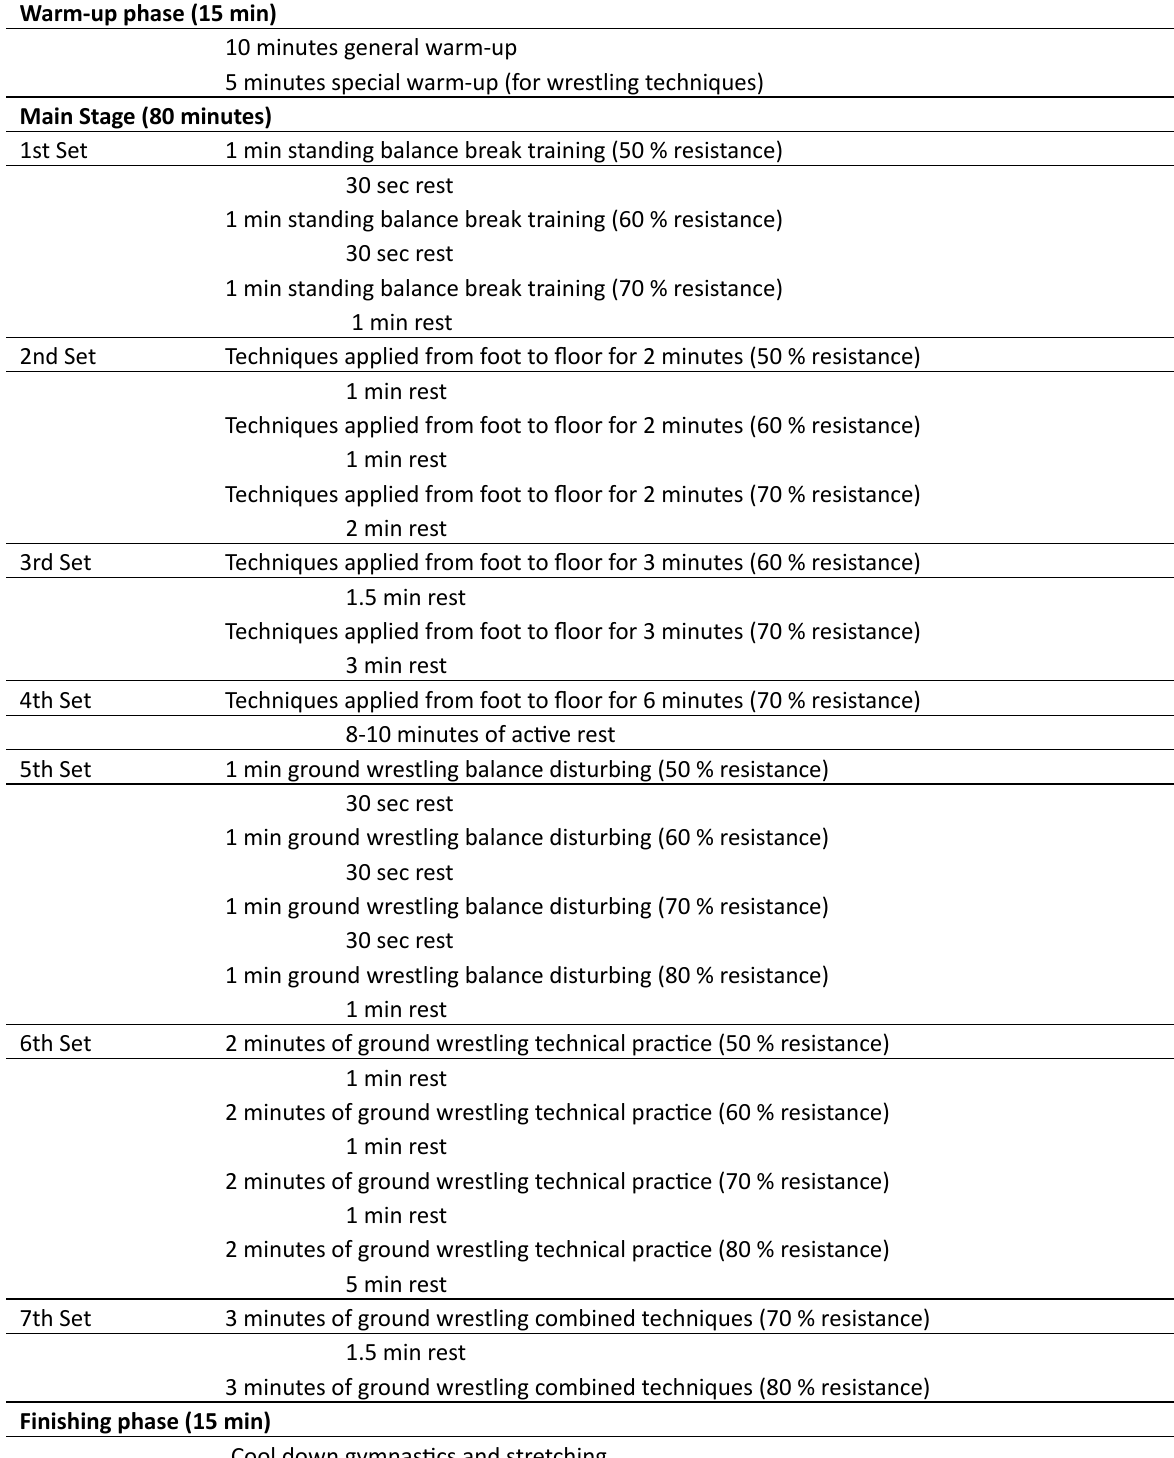
Table 1. Unit training application for acute dehydration Warm-up phase (15